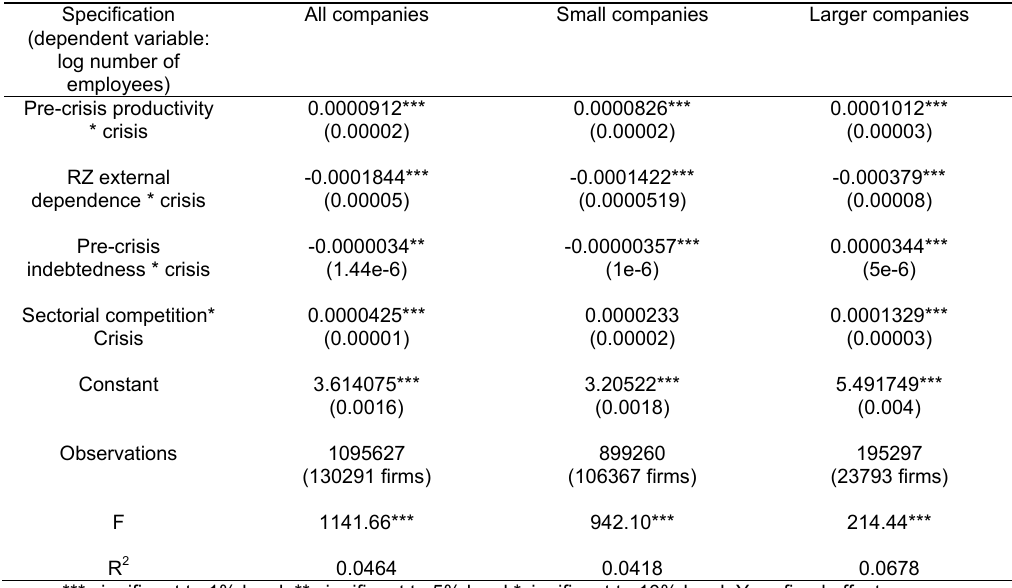
Table A.3. Results including sectorial competition